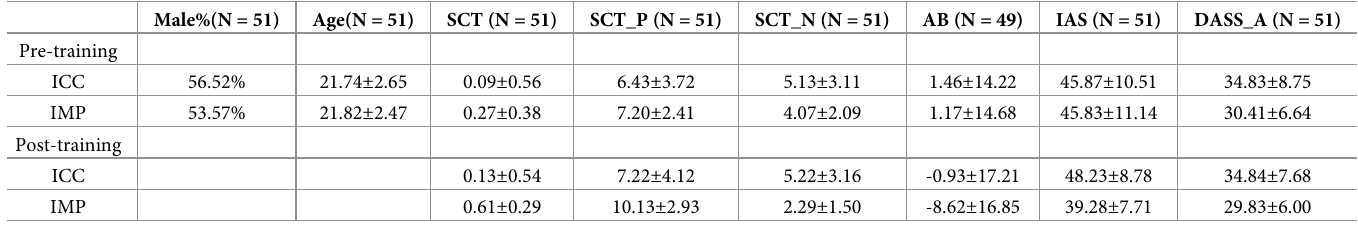
Table 1. Means and standard deviations for cognitive bias and social anxiety for intervention and control